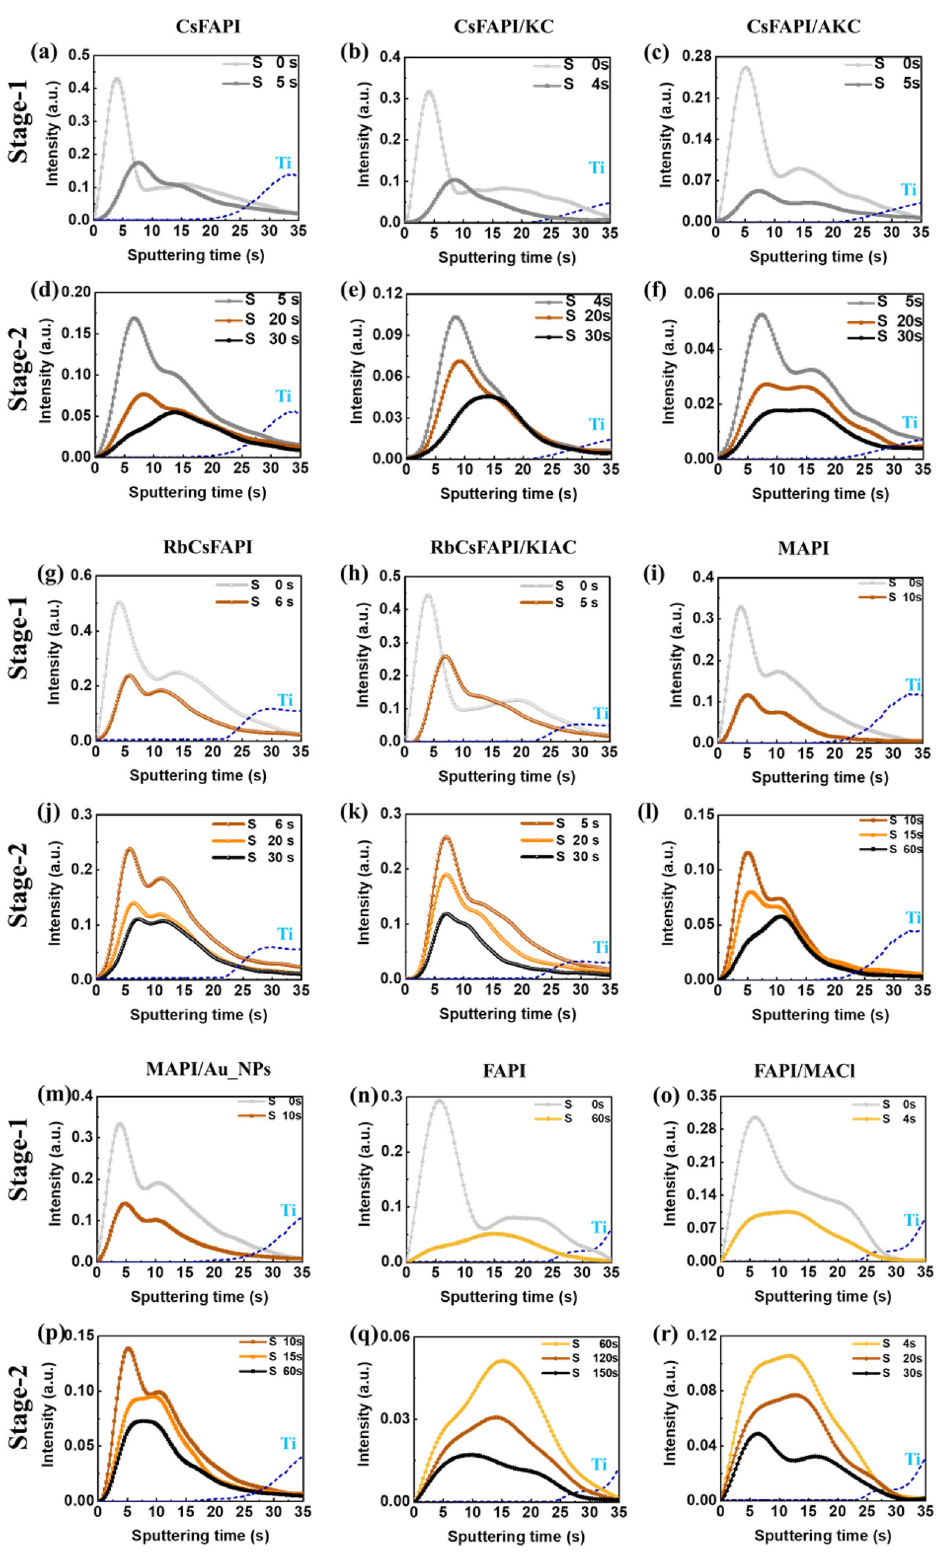
Fig. 4|EvolutionofGD-OESsulfurelement(S)pro fi leuponthermalannealing. Various perovskite precursor layers are followed upon Stage-1 and Stage-2 of thermal annealing. a CsFAPI at stage-1. b CsFAP/KC at stage-1. c CsFAPI/AKC at stage-1. d CsFAPI at stage-2. e CsFAP/KC at stage-2. f CsFAPI/AKC at stage-2. g RbCsFAPI at stage-1. h RbCsFAPI/KIAC at stage-1. i MAPI at stage-1. j RbCsFAPI at